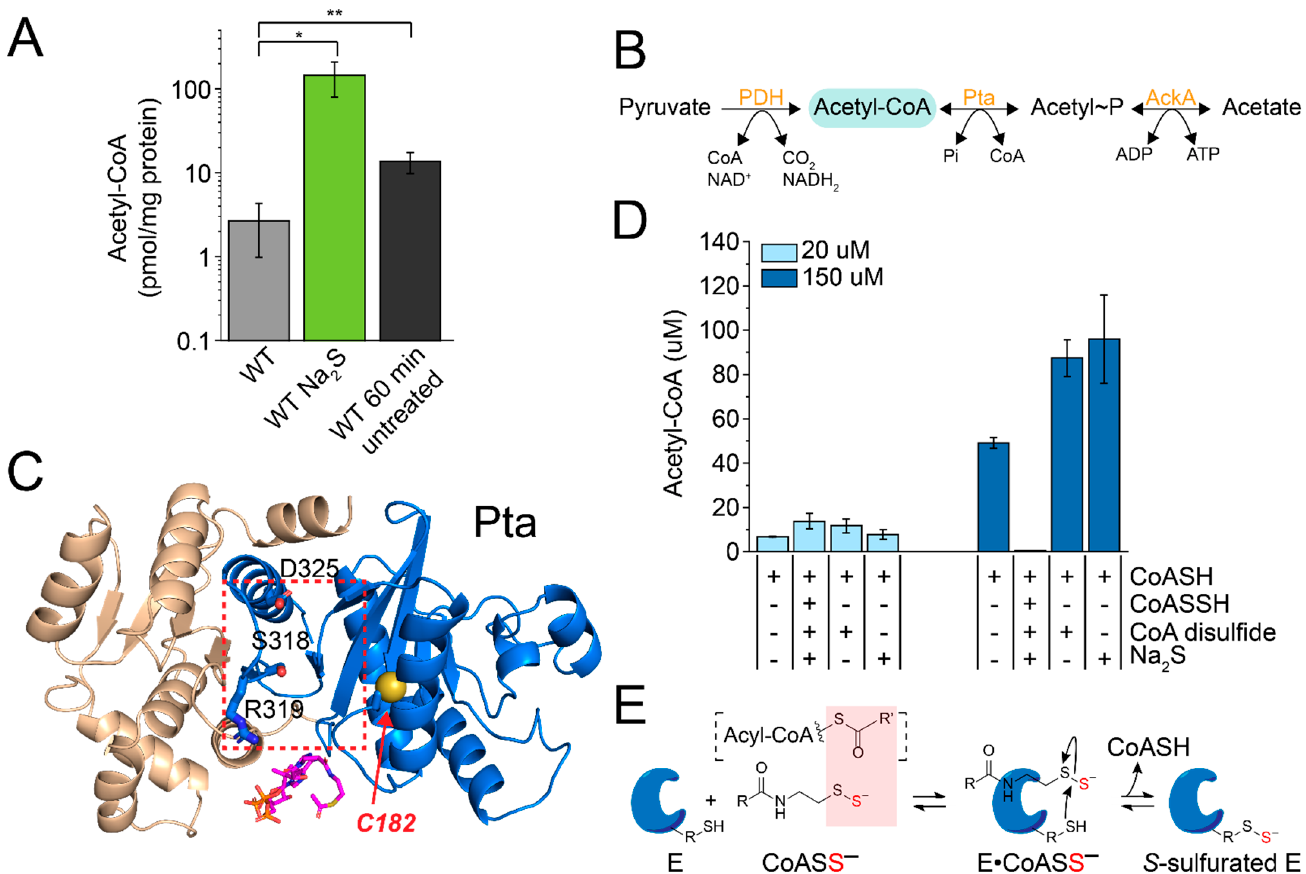
Figure 4. Acetyl-CoA accumulation via enzyme inhibition by CoASSH. ( A ) Quantitation of acetyl- CoA in WT cells treated with or without exogenous Na 2 S. Values represent the means ± S.D. derived from results of n = 5 replicates, with statistical significance established using a paired t -test to wild- type untreated cells (** p ≤ 0.01, * p ≤ 0.05). ( B ) Metabolic pathways for the biosynthesis of acetyl- CoA in E. faecalis . ( C ) Ribbon representation of an AlphaFold2 [67,68] model of Ef Pta. The cleft be- tween domain I ( wheat ) and domain II ( blue ) defines the active site ( red box), where R319 provided electrostatic stabilization to the nucleotide end of bound CoASH (magenta , from PDB 6IOX), S318 hydrogen-bonds to the terminal thiol and D325 is the catalytic base [69]. C182, with the sulfur atom shown as a yellow sphere, is extensively persulfidated in cells. ( D ) Impact of CoASSH on the yield of acetyl-CoA by Ef Pta. ( E ) Protein S -sulfuration via CoASSH poisoning. Binding of CoASSH to an acyl-CoA or CoA-utilizing enzyme, E, which has a nearby Cys that participates in persulfide transfer from CoASSH results in the release of the free thiol and a S -sulfurated enzyme.